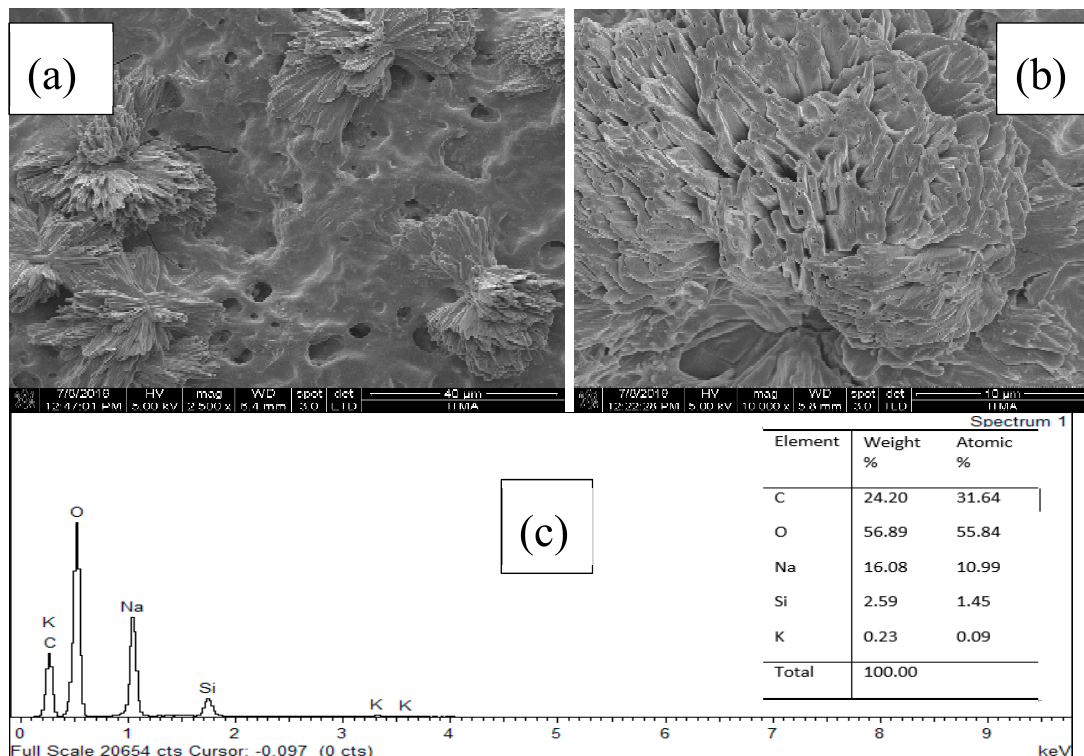
Figure 8. FESEM at ( a ) 40 µm ( b ) 10 µm and ( c ) EDx of tapioca-derived carbon dots.